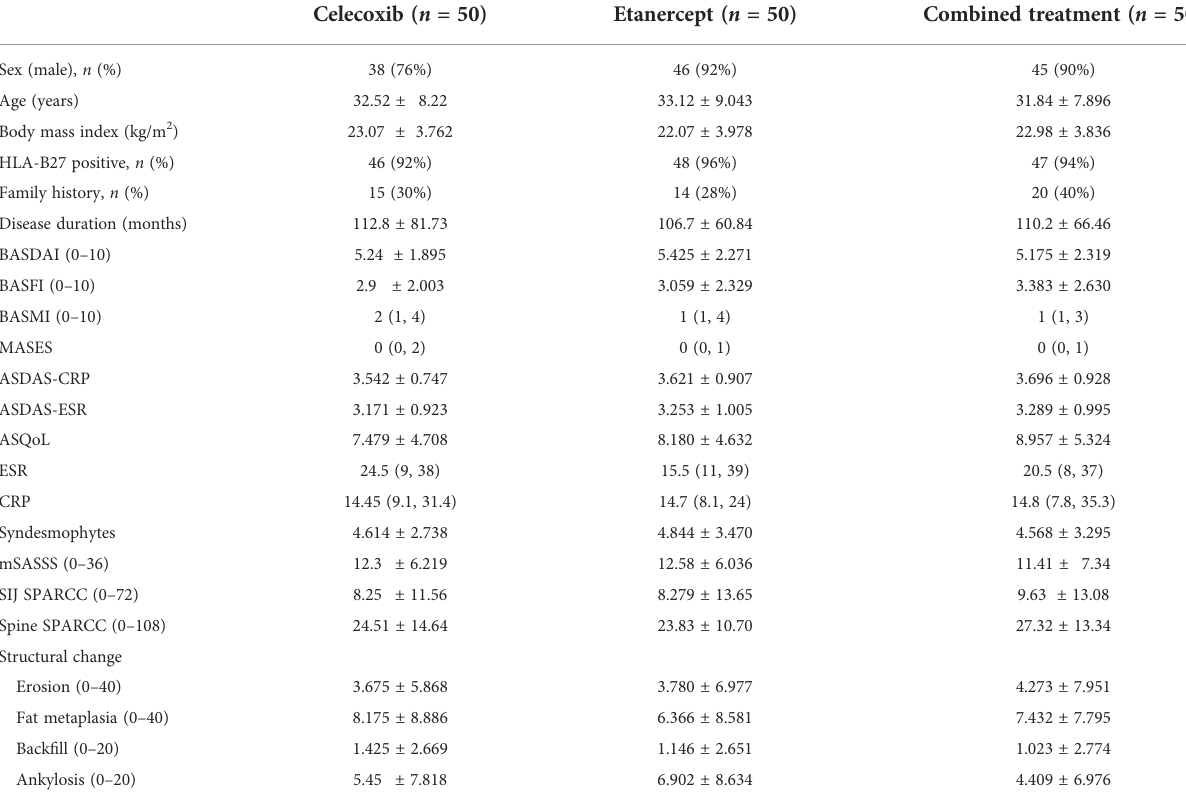
TABLE 1 Baseline characteristics of AS patients in the three treatment